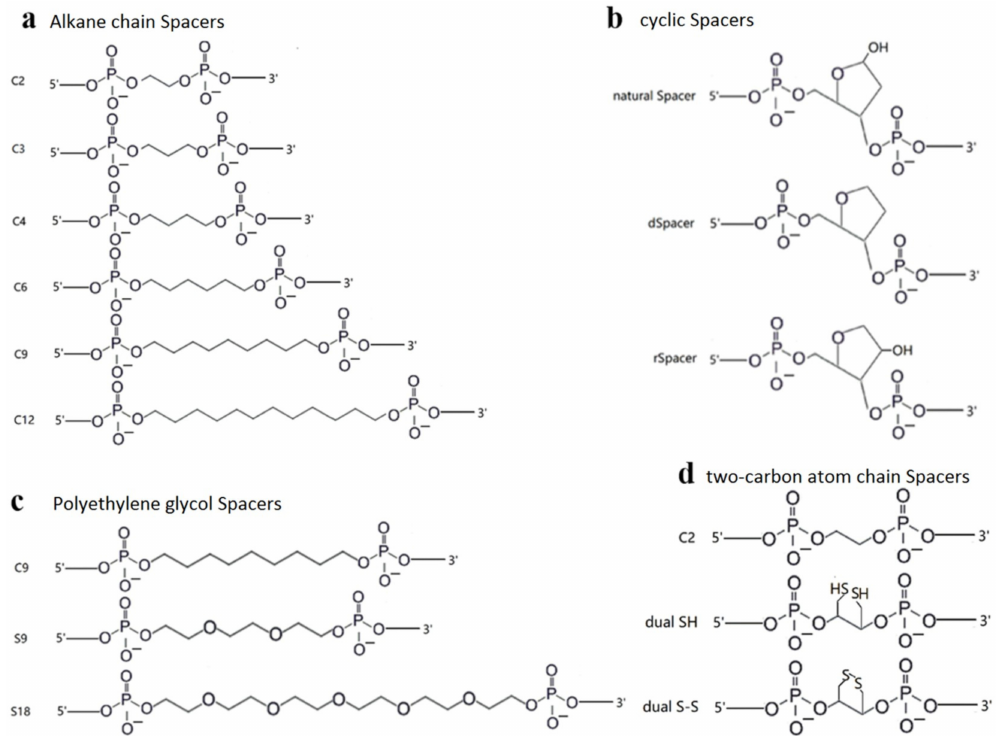
Figure 2. Structures of various AP site analogues. The molecular structure of ( a ) alkane chain Spacers (Spacer Cn), ( b ) cyclic Spacers (natural Spacer, and synthetic dSpacer and rSpacer), ( c ) polyethylene glycol Spacers (Spacer 9 and Spacer 18), and ( d ) two-carbon atom chain Spacers (Spacer C2, Dual SH, and disulfide (S-S)).